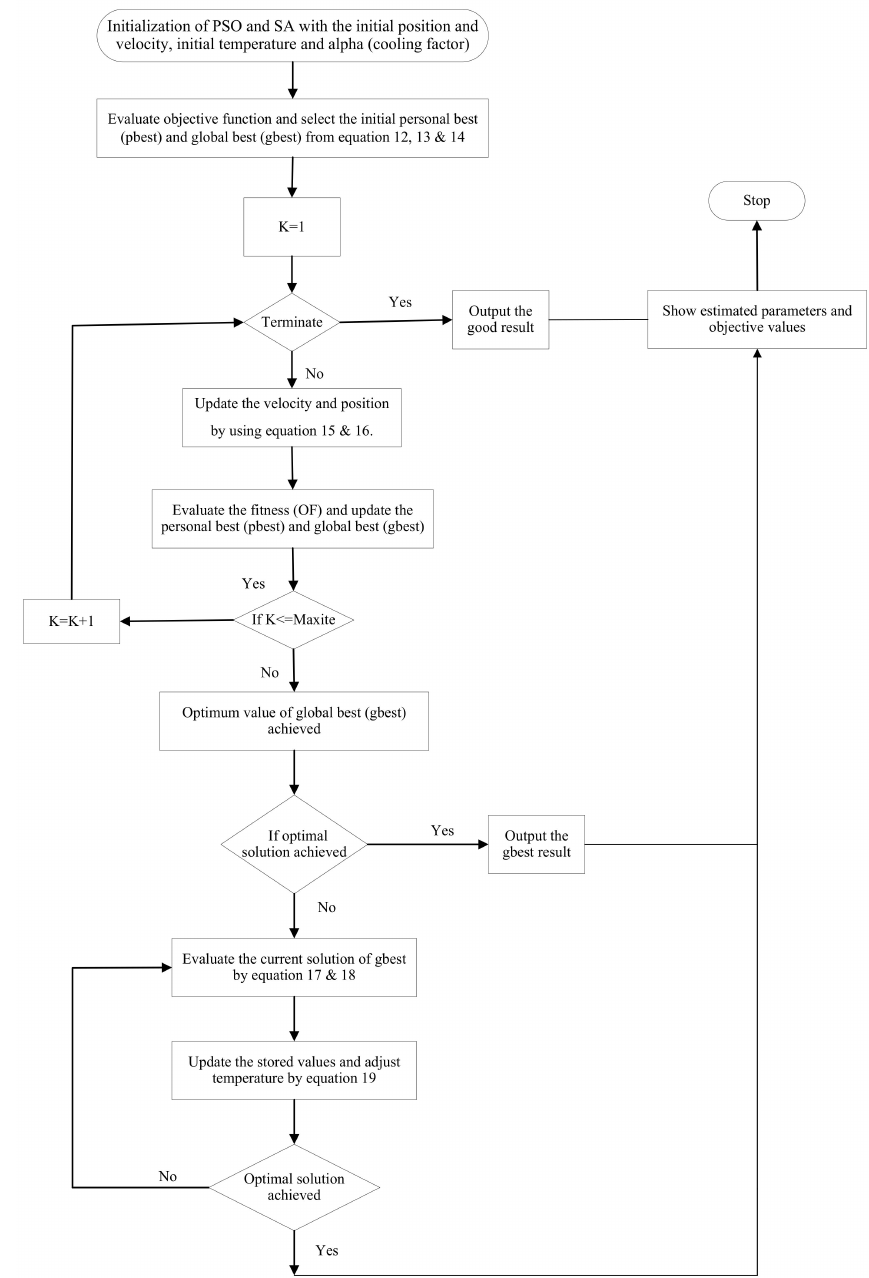
Figure 2. Flow chart of the proposed